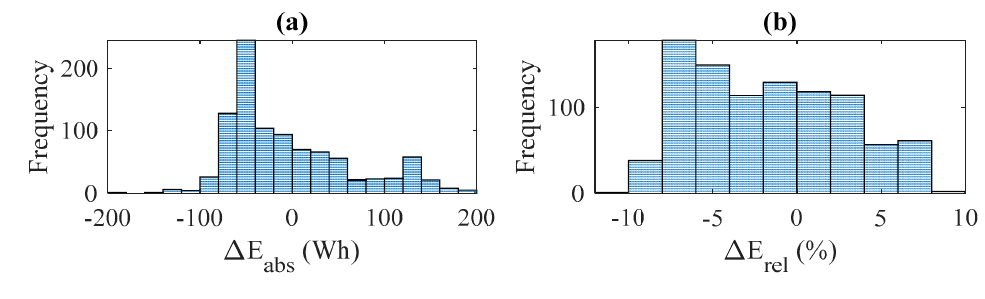
Figure 16. HVAC power estimation error: histograms of ∆ E abs ( a ) ∆ E rel ( b ). Table 5. Mean value and standard deviation of ∆ E abs and ∆ E rel for the four tested driving cycles. INRETS Cycles INRETS